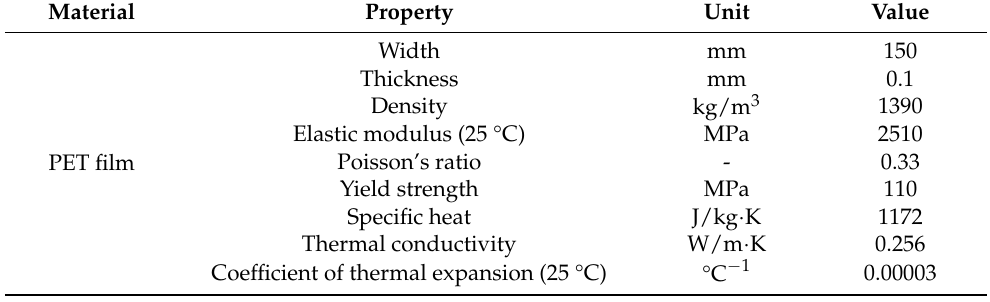
Table 1. Properties of polyethylene terephthalate (PET) film.